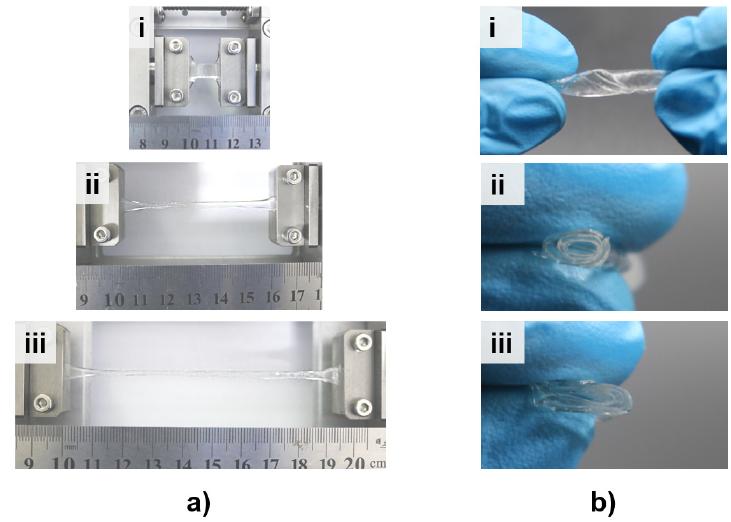
Figure 3. ( a ) Elongation test of the fabricated DN ionic hydrogel at 0% (i), 750% (ii) and 1180% (iii); ( b ) Photographs of the DN ionic hydrogel membrane at twisting (i), rolling (ii) and folding (iii) state.